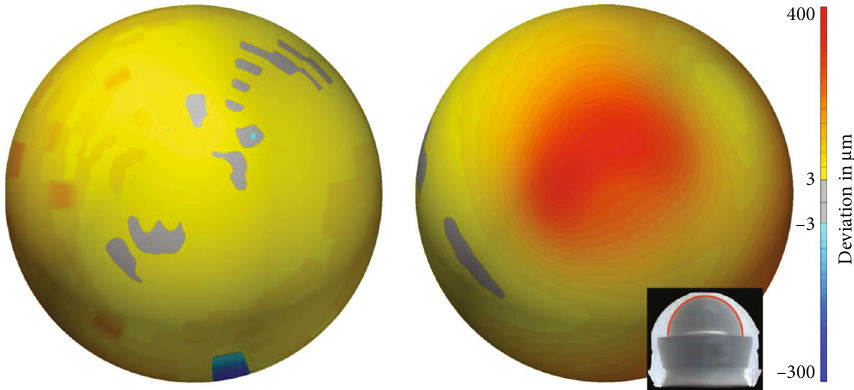
Figure 9: Deviation from a perfect sphere of the PE contact area of the cup liner (a) ( d = 35 : 936mm ) and the head liner (b) ( d = 22 : 070mm ). Red areas indicate PE wear, and blue areas indicate